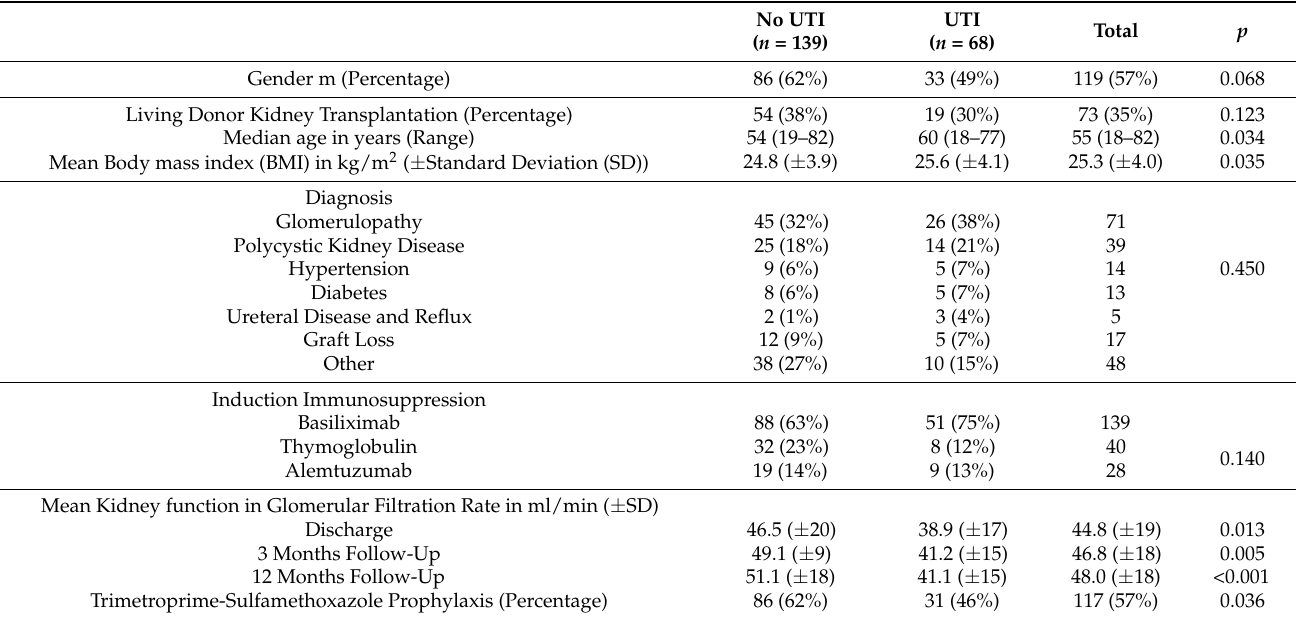
Table 1. Patient